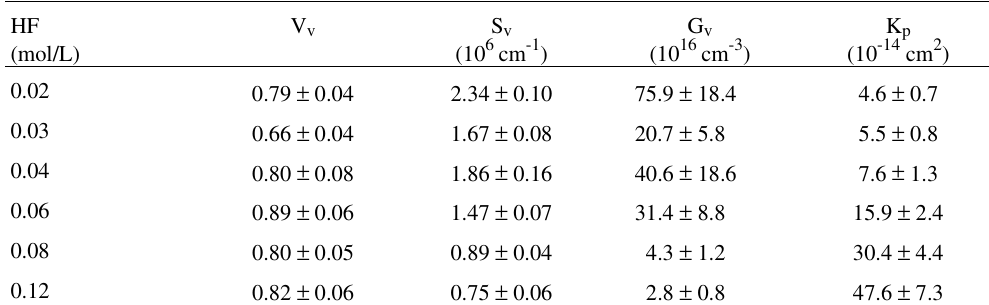
Table 3. Values of volume fraction of pores (V V ), solid-pore surface area per unit volume (S V ), genus (G V ) and permeability (K P ) for the silica gels catalyzed with HNO 3 and HF.